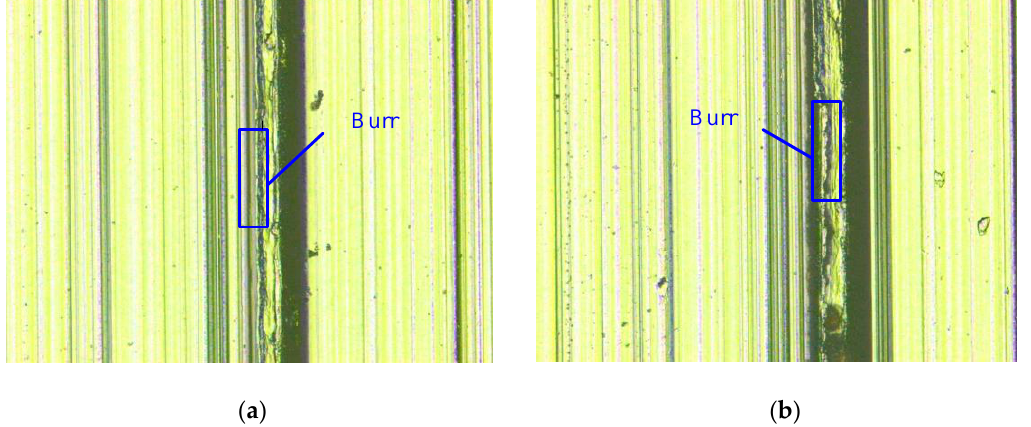
Figure 9. The burrs on the microtextures at different feeds: ( a ) 2 μm/r , ( b ) 12 μm/r. Table 7. Machining condition of micro cutting to optimize the rotation speed.